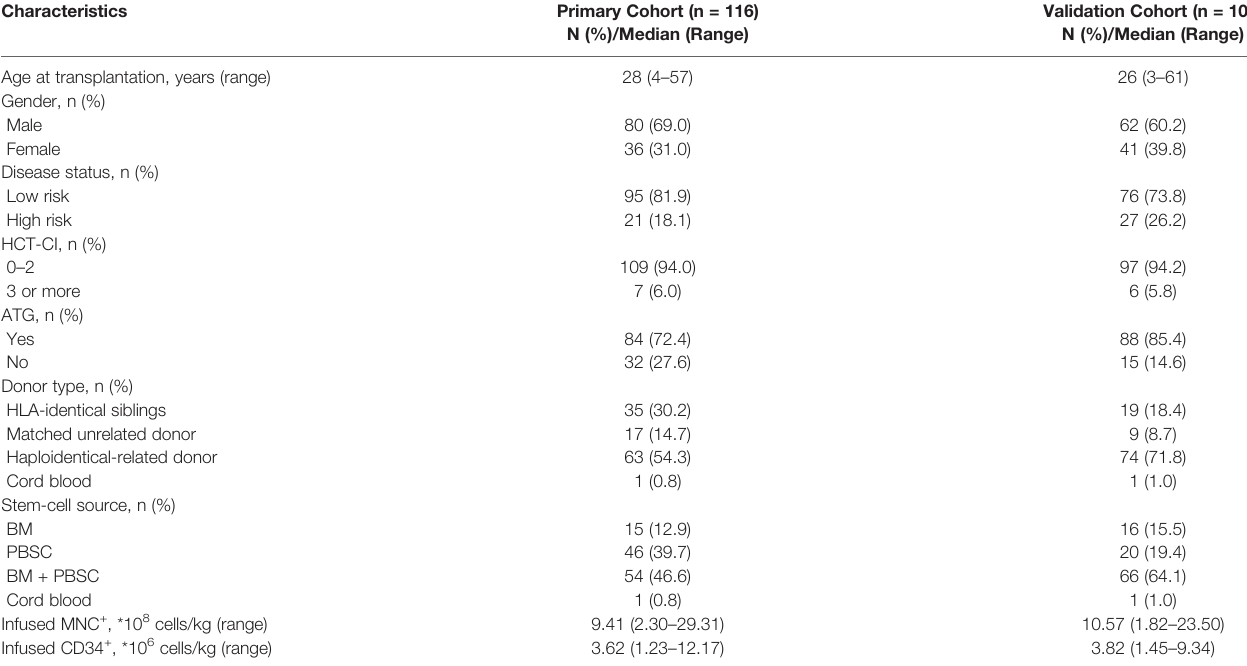
TABLE 1 | Baseline patient and transplantation